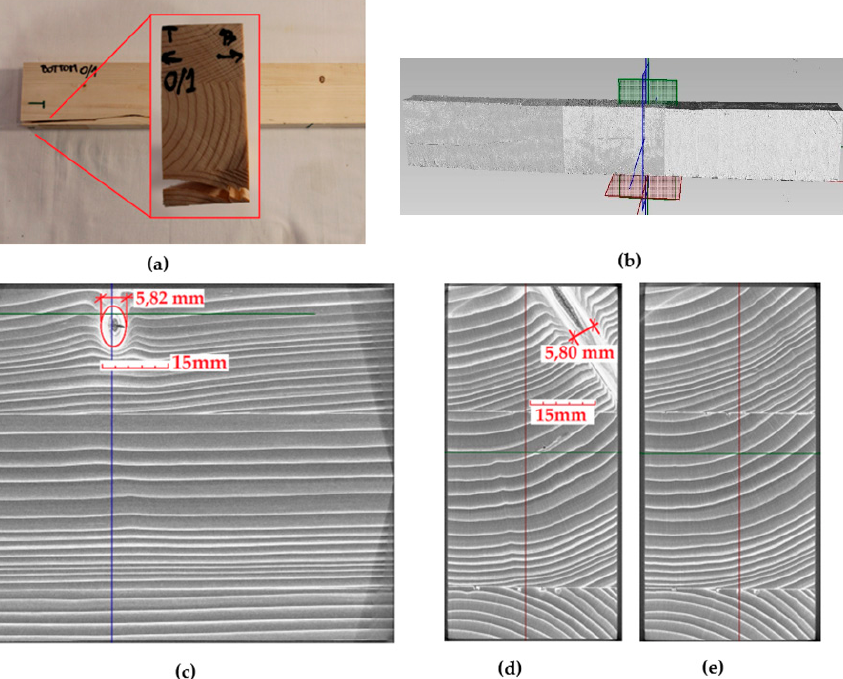
Figure 12. Part of reference Beam No. 0/1—condition after failure: ( a ) view of the failure, ( b ) view of the scanned beam, ( c ) longitudinal cross-section in the middle of the span, ( d ) cross-section in the place of the knot, ( e ) transverse cross-section in the middle of the span.